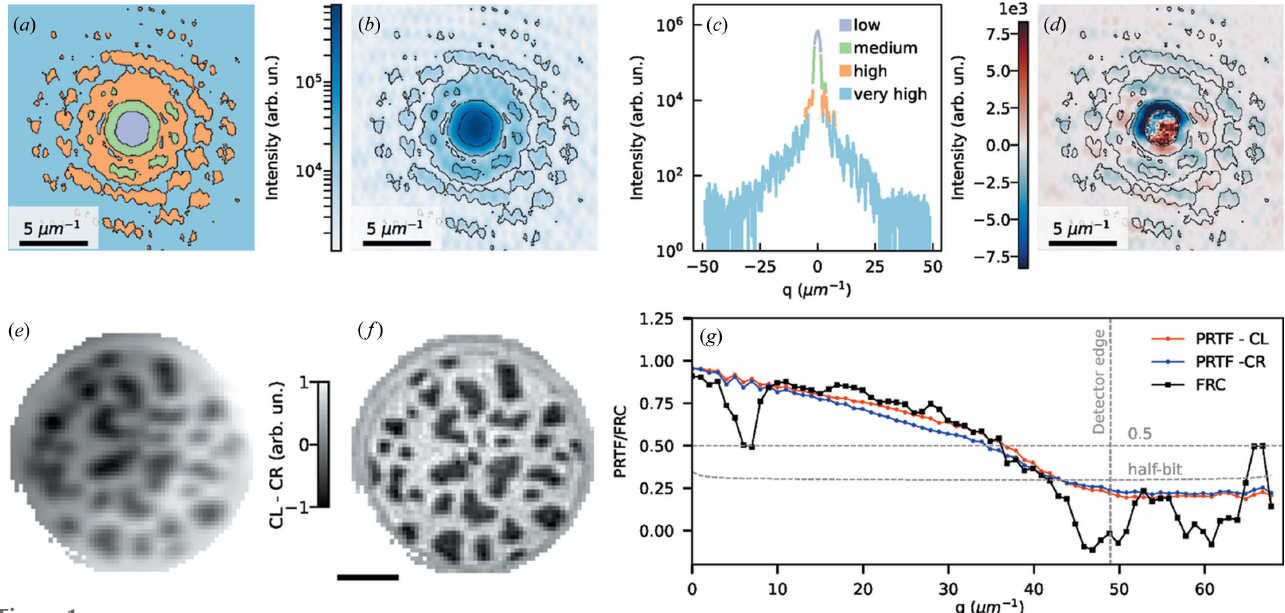
Figure 1 Results of FTH and phase retrieval with the PERCIVAL detector. ( a ) Map of fixed gains used for the composed final hologram (central part only). For color definition see the legend in ( c ). ( b ) Hologram [same crop as in ( a )] assembled from all data recorded with different gain settings and left-handed polarised soft X-rays. Contour lines mark transitions from one fixed gain region to the next. ( c ) Line scan of the hologram in ( b ) through its center. Pixel values using different gains are depicted using different colors. ( d ) Difference hologram corresponding to ( b ). ( e ) FTH reconstruction of ( d ) revealing magnetic domains inside the field of view and ( f ) corresponding phase-retrieved reconstruction. Scale bar is 300 nm. ( g ) Phase-retrieval transfer function and Fourier ring correlation of the reconstruction in ( f ). Gray dashed lines indicate the 0.5 and half-bit